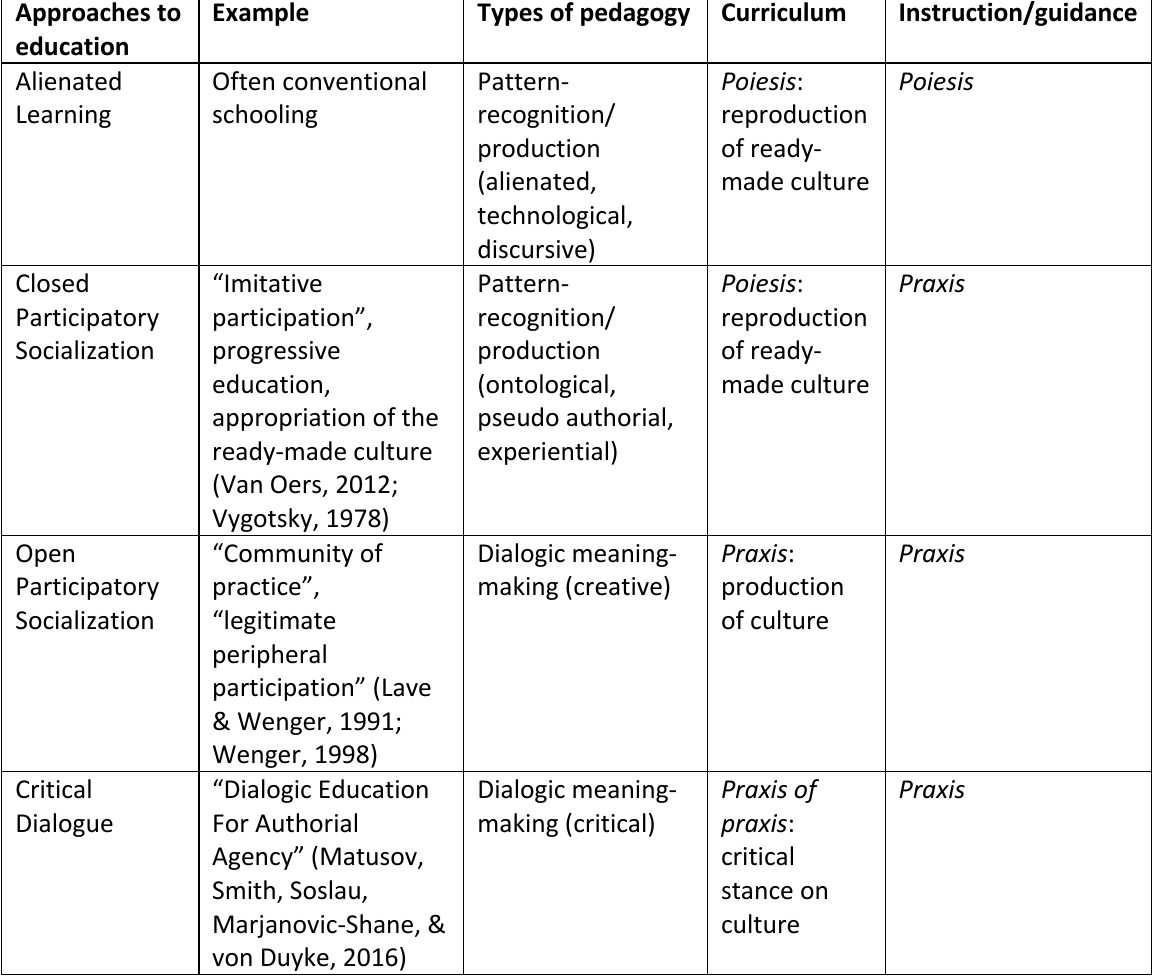
Table 1: Diverse approaches to education (based on Matusov & Marjanovic-Shane, 2012, p. 165) Approaches